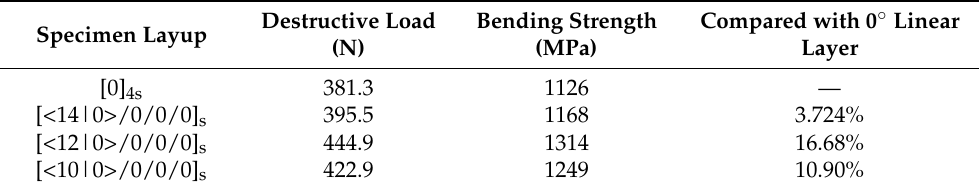
Table 2. The bending strength of different geodesic curvature curve layers and 0° linear layer specimens.